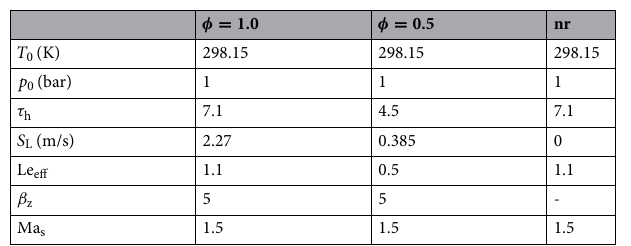
1.0 at different resolutions. =